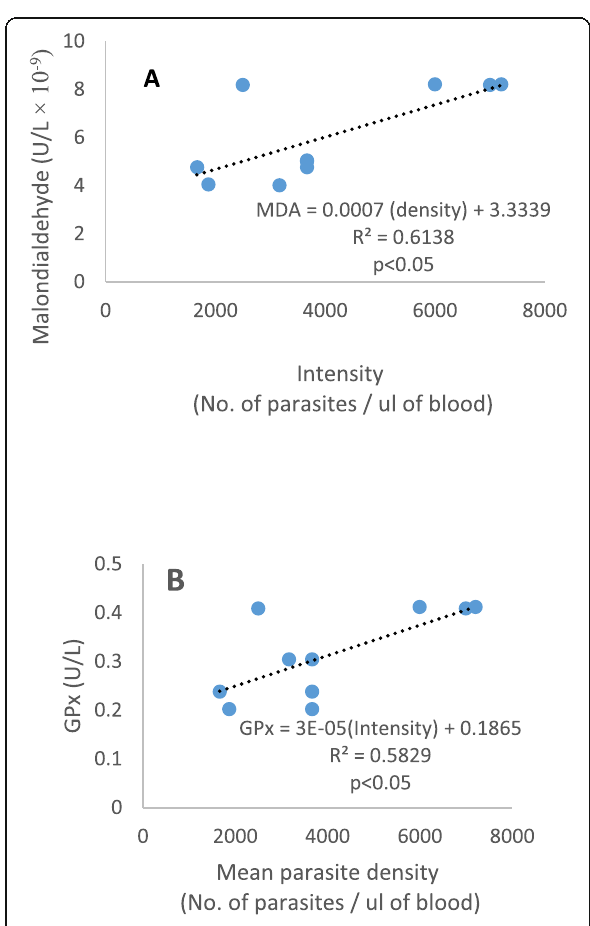
Fig. 1 Relationship between the mean parasite density and a MDA and b